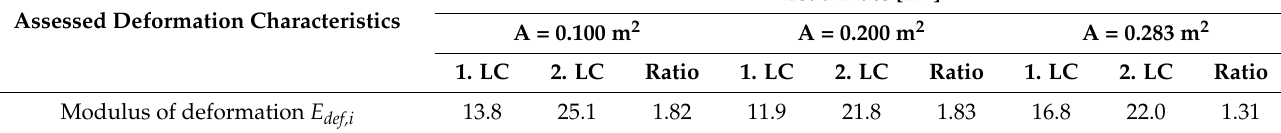
Table 3. Recapitulation of SLT results with different size of load plate.